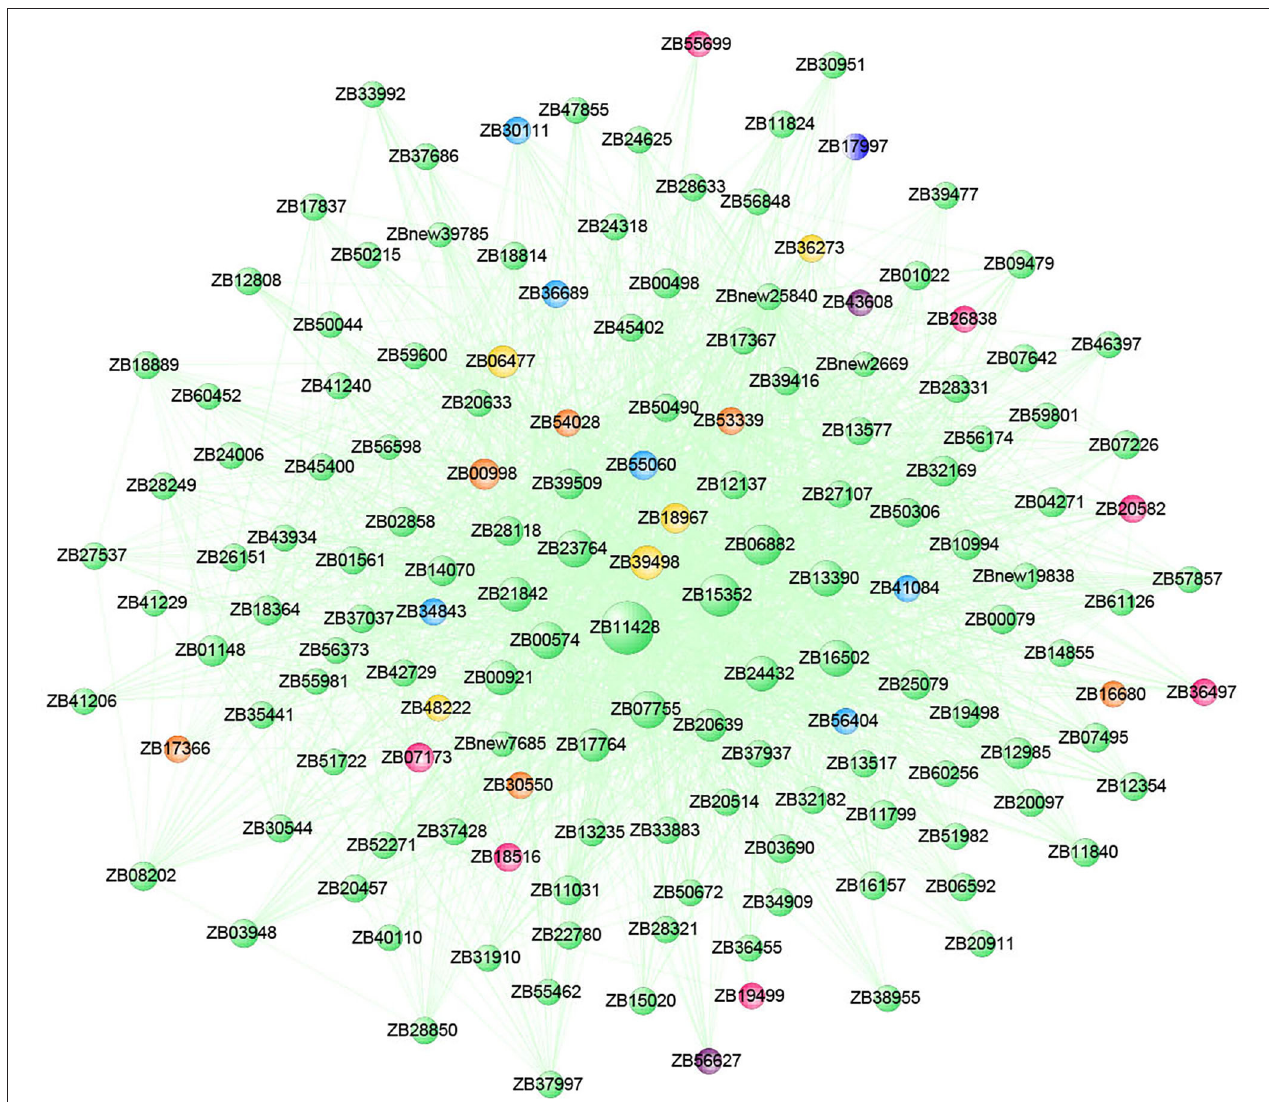
FIGURE 9 | Co-expression network of the top 150 hub genes from the MEhoneydew module. The size of each gene node in the figure represents the connectivity of genes, and the node color represents the category.